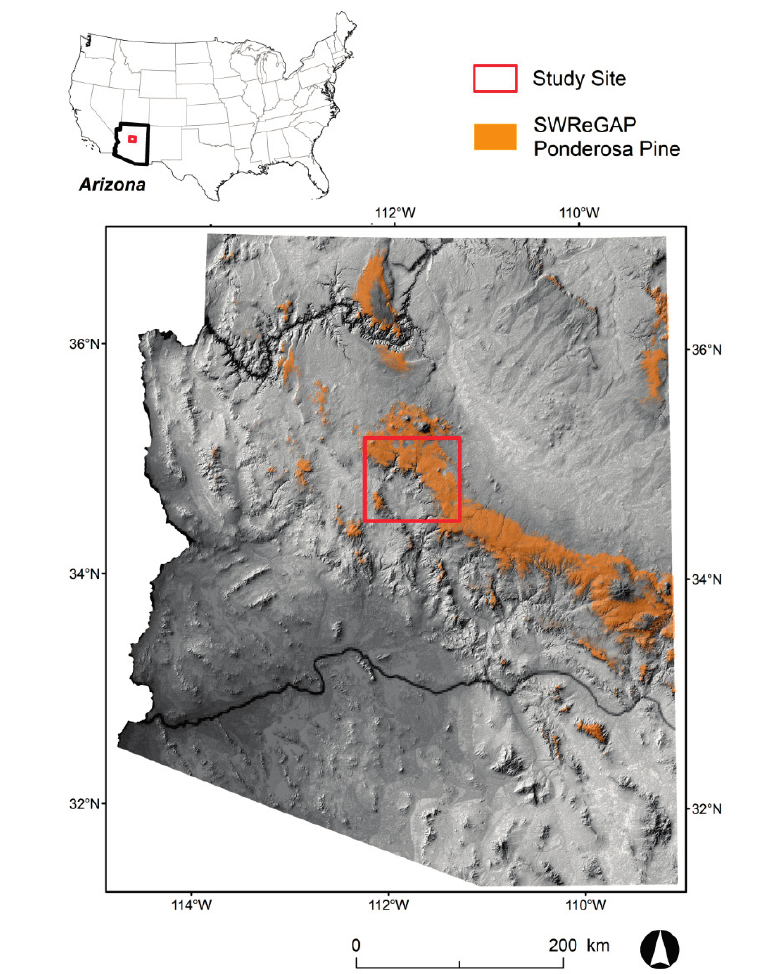
Figure 1. Location of study area and extent of Southwest Regional Gap Analysis Program (SWReGAP) Southern Rocky Mountain Ponderosa Pine Woodland vegetation class in the state of Arizona, USA.